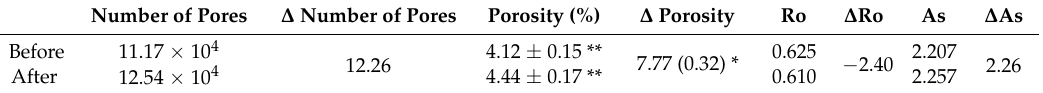
Table 3. Number of pores, optical porosity, roundness (Ro) and aspect ratio (As) measured by OIA of carbonate thin sections before and after SC CO 2 exposure. ( ∆ : relative variation; * absolute variation; ** uncertainly 1.26% given by Oviedo-IGME OIA